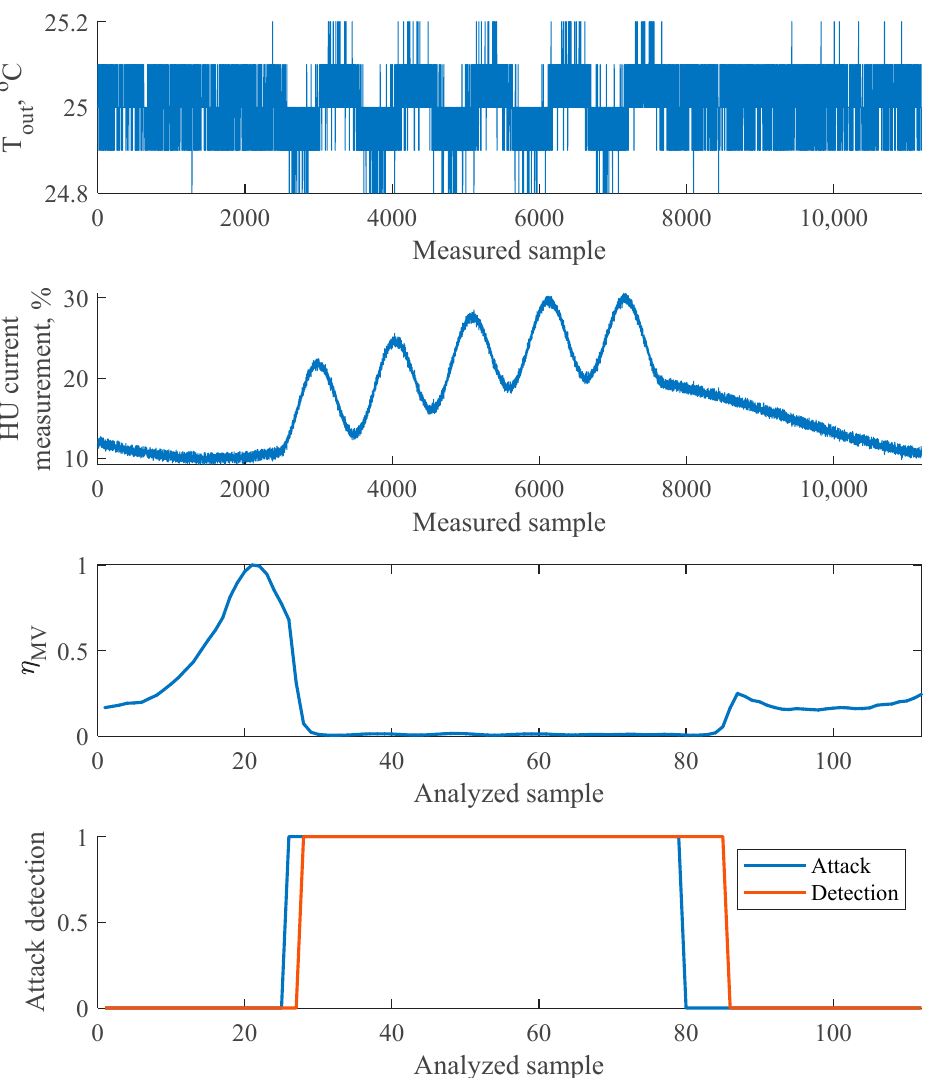
Figure 10. Sinusoidal attack signal on top of a low-frequency natural sinusoidal disturbance.